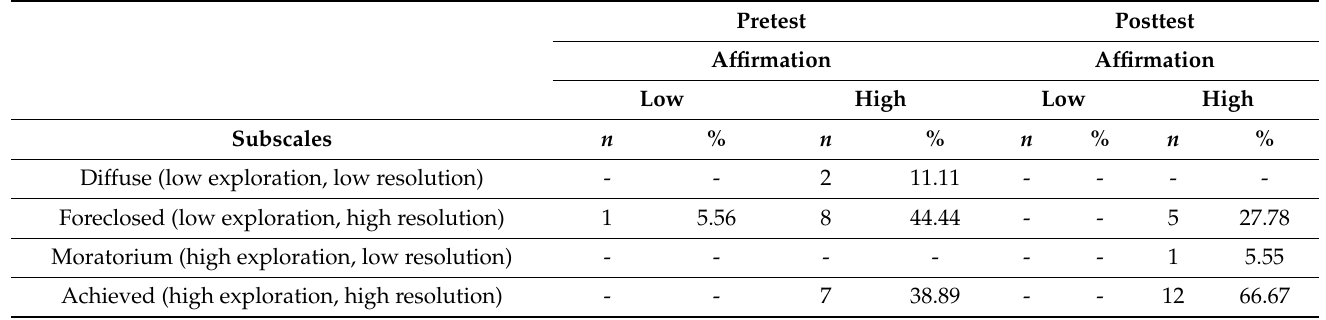
Table 6. Ethnic Identity Scale Results ( N =